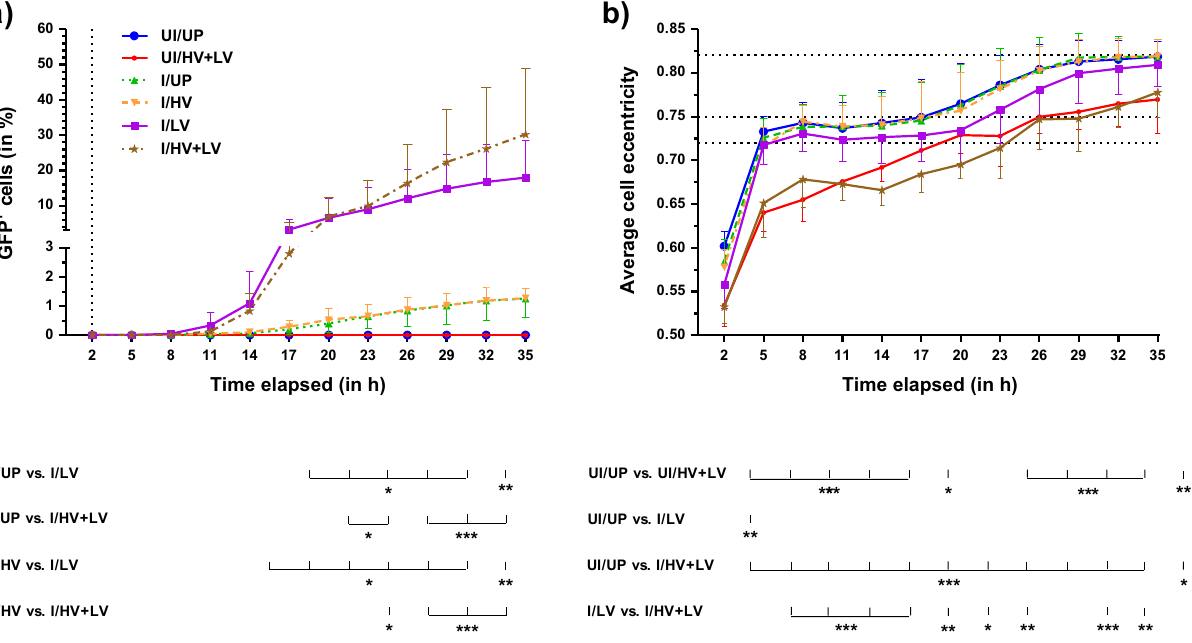
Figure 1. Real-time monitoring of GFP conversion of L929 cells after adenovirus infection and delivery of various types of electric pulses. ( a ) Percentage of GFP-converted cells as a function of elapsed time (in h), for each type of electric pulse. GFP + cells percentage resulted from the ratio of fluorescent adherent cell number to total adherent cell number assessed by image analysis using the IncuCyte Zoom software. For optimal presentation of the initial stage of GFP expression, Y-axis is broken to indicate the change of scale above 3%. ( b ) Average cell eccentricity variations (from 0 up to 1) as a function of elapsed time (in h), calculated using the IncuCyte Zoom software. These variations reflect adherent cell recovery several hours after treatment. Plateau values of eccentricity (at 0.72, 0.75 and 0.82) are indicated by horizontal dotted lines. Treatment procedures for L929 cells were as indicated in the “Materials and methods” section, with the MOI set at 4 × 10 4 vp/cell. Image acquisition started 2 h after the treatment (vertical dotted line on the graph ( a ) and was repeated every 3 h for 35 h. Abbreviations and curve symbols: UI uninfected, I infected, UP unpulsed, LV/HV/HV + LV application of low, high, high plus low voltage pulses, respectively; UI/UP (blue filled asterisk), UI/HV + LV (ref filled circle), I/UP (green filled triangle), I/HV (yellow filled inverted triangle), I/LV (violet filled square), I/HV + LV (gold filled star). Data are presented as means ± SD (with n = 3 for each condition). Error bars are indicated either up or down, depending on experimental points, for optimal visualization of the curves. Statistical significances: * p < 0.05, ** p < 0.01 and *** p < 0.001 stand for comparisons of GFP + cells in ( a ) and average cell eccentricity in ( b ), at each time interval and between different experimental conditions indicated below both graphs (two-way ANOVA for repeated measures with Bonferroni’s post-test).